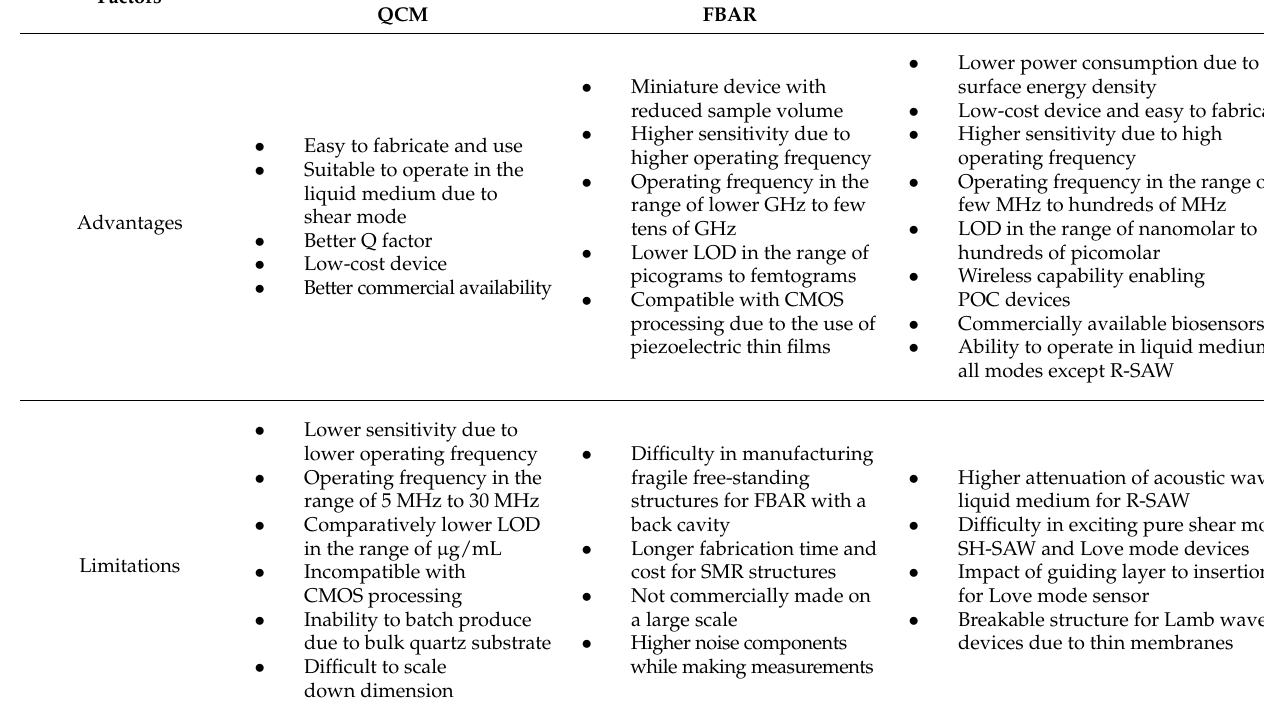
Table 3. Summary table for the comparison of acoustic sensors with the advantages and limitations. BAW SAW Factors QCM